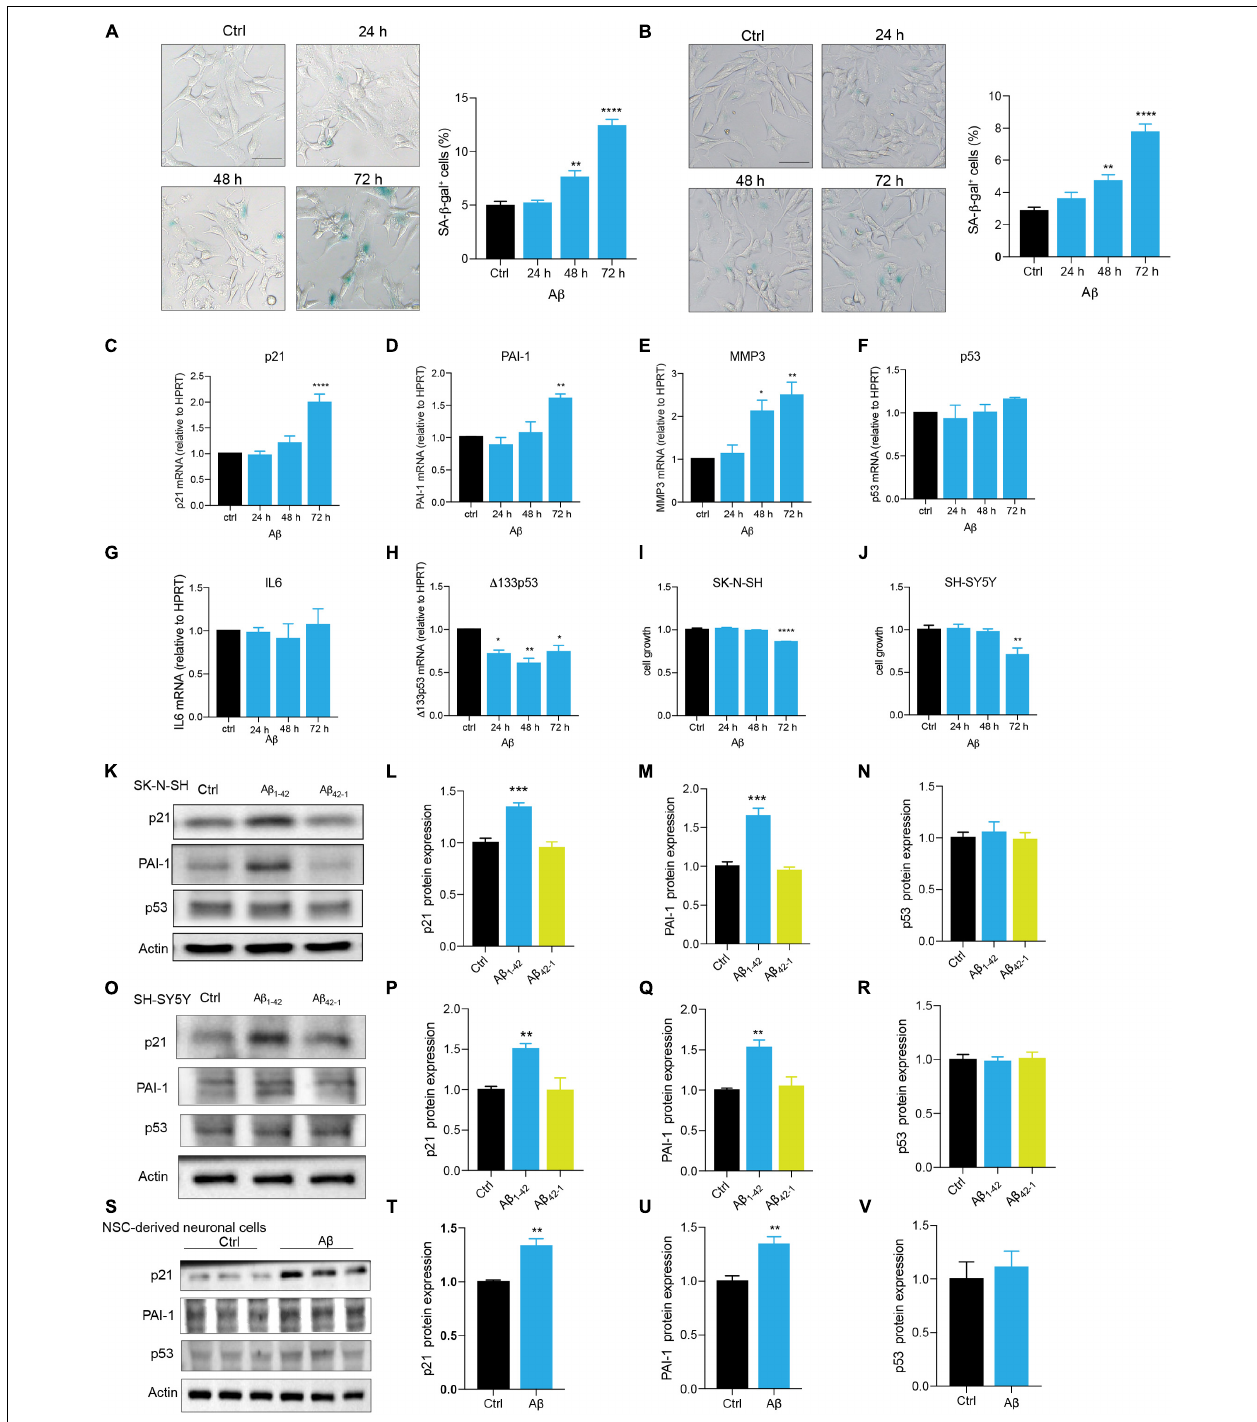
FIGURE 1 | A β accelerated cell senescence in human neuronal cells. (A) The representative images of SA- β -gal staining in SK-N-SH cells treated by A β (5 µ M) at indicated time, and quantification of relative number of SA- β -gal-positive cells. The images were captured by Olympus IX73. Scale bars, 50 µ m. (B) The representative images of SA- β -gal staining in SH-SY5Y cells challenged by A β (5 µ M) at indicated time, and quantification of relative number of SA- β -gal-positive cells. The images were captured by Olympus IX73. Scale bars, 50 µ m. (C-H) p21 (C) , PAI-1 (D) , MMP3 (E) , p53 (F) , IL6 (G) , (cid:49) 133p53 (H) mRNA levels were measured after treatment with A β (5 µ M) at indicated time. (I-J) Cell growth was detected by luminescent cell viability assay in SK-N-SH cells (I) and SH-SY5Y cells (J) challenged by A β (5 µ m) at indicated time. (K-N) Cells were incubated with A β 1 - 42 (5 µ M) or A β 42 - 1 (5 µ M) for 72 h in SK-N-SH cells, and cell lysates